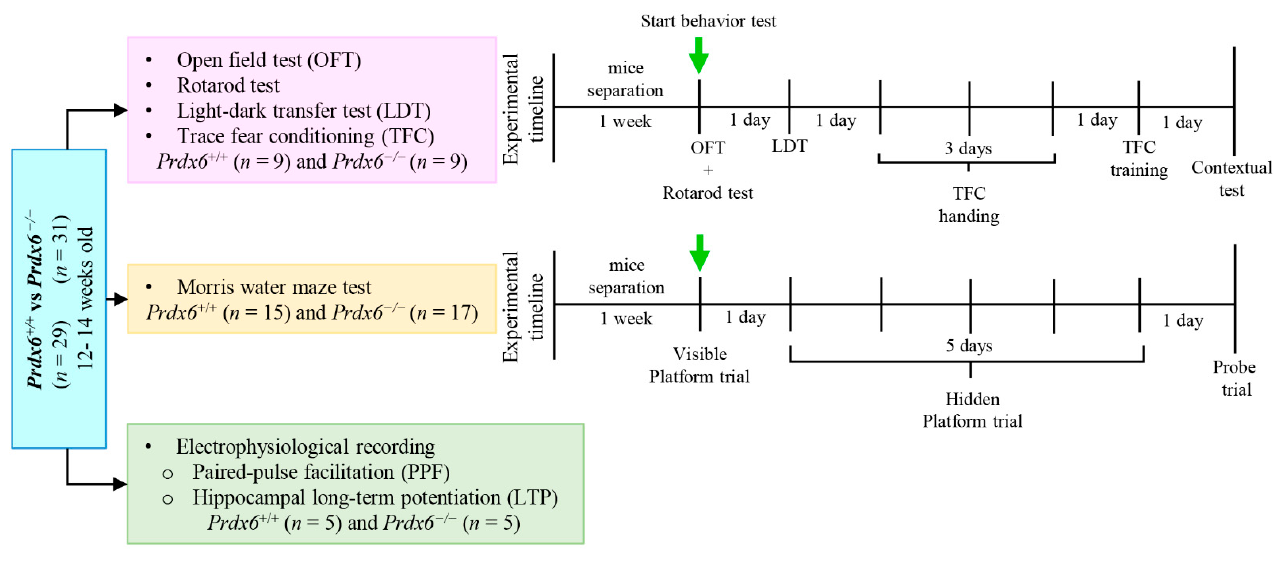
Figure 1. Experimental design and timeline. A total of 60 (12–14 week-old) mice, 29 Prdx6 +/+ and 31 Prdx6 − / − , were divided into 3 batches and used in three sets of experiments. The first batch of mice was used to test a series of behavior tests, including OFT, rotarod test, LDT, and TFC. The second batch of mice was used to measure the spatial memory to MWM test. The third batch of mice was used to investigate the hippocampal synaptic plasticity by PPF and LTP recording.